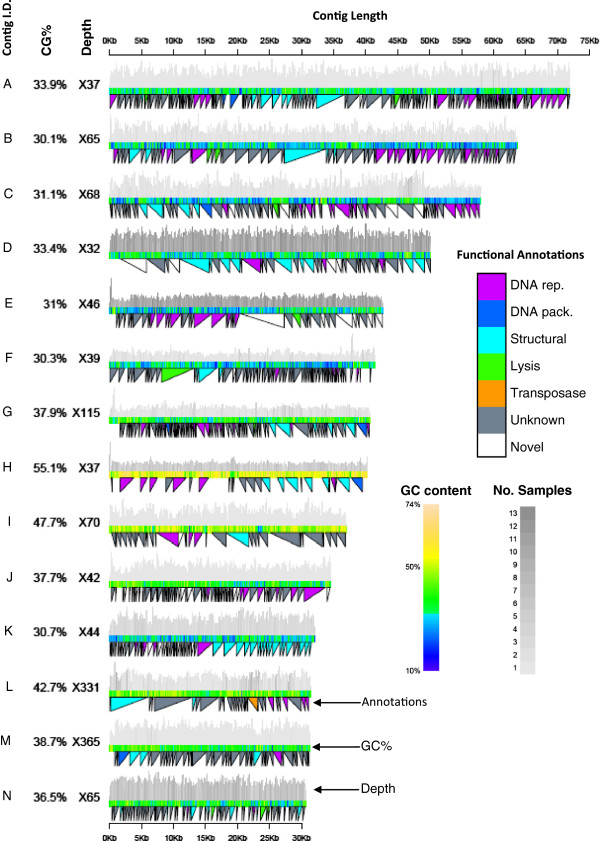
Virome contigs greater than 30 kbp. The median coverage of the contig and the GC% are shown to the left of each contig. The colour of the centre bar represents the GC% in a 100 bp sliding window. The grey lines on top of each contig represent the sequence depth, as determined by aligning reads to the contig using BWA. The shade of grey represents the number of different samples that have reads mapping to that position. The triangles below the contig show the function of the annotation at that position. DNA rep. = DNA replication and repair, DNA pack. = DNA packaging, Unknown = all significant BLAST hits were to unannotated subjects, Novel = no significant BLAST hit.